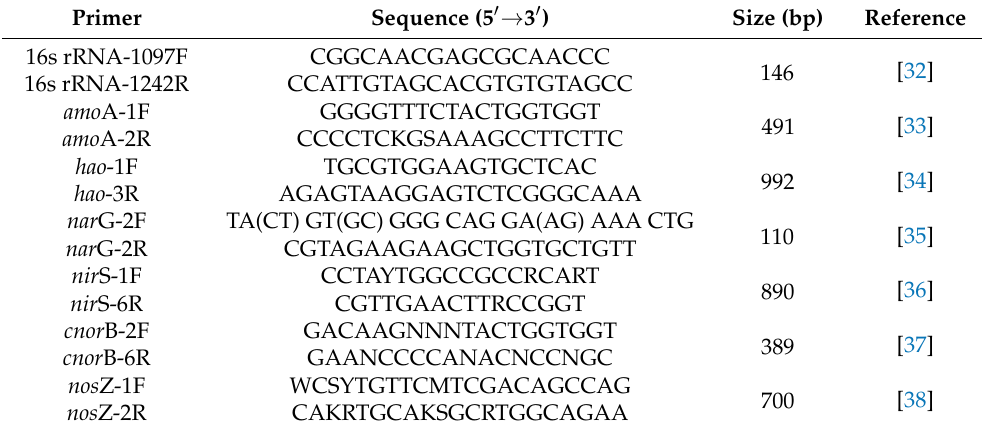
Table 2. Primer sets for